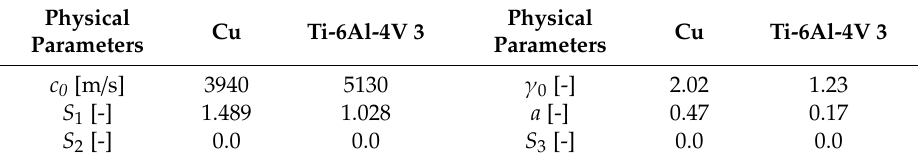
Table 3. Equation of state (EOS) constants of copper and Ti-6Al-4V